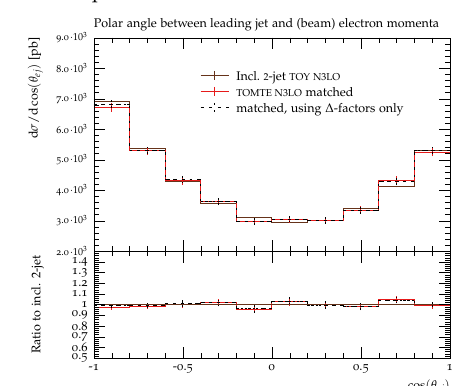
(b) Separation of the 3rd and 4th hardest jets, as proxy for (inclusive) observables depending on at least four partons.